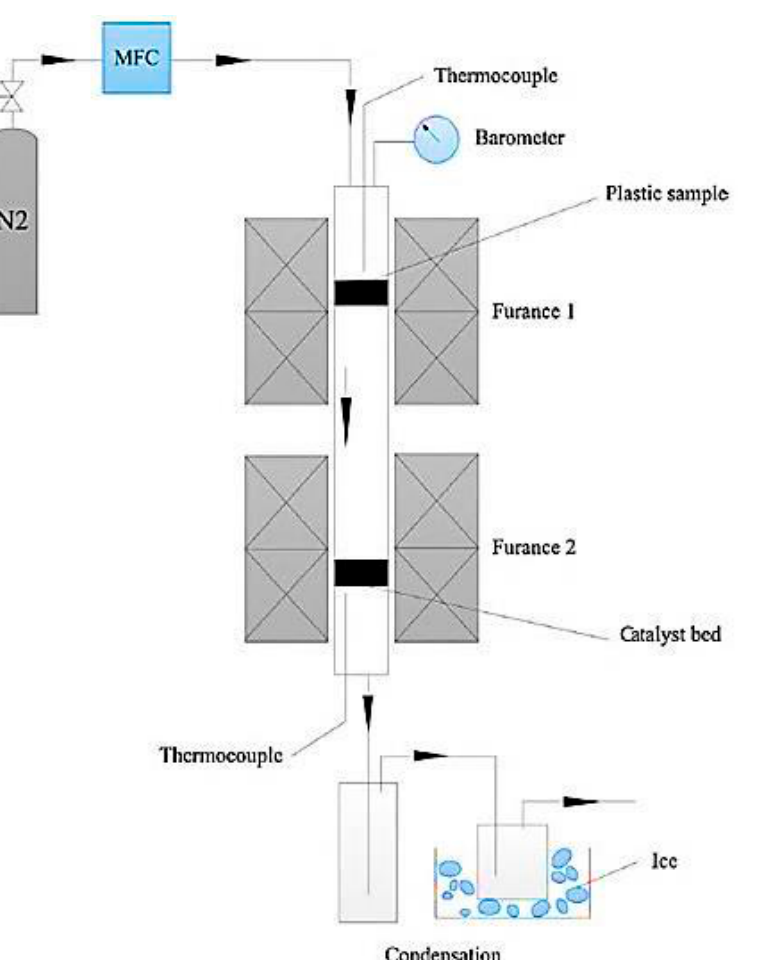
Figure 3. Schematic diagram of two-stage pyrolysis reactor system (adapted from [74]).